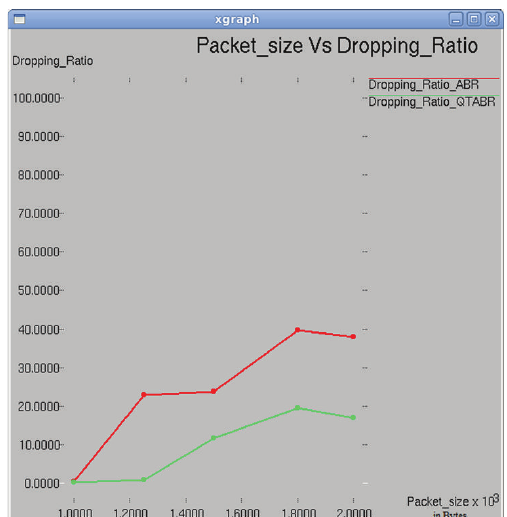
Figure 11: Number of nodes versus packet dropping ratio.